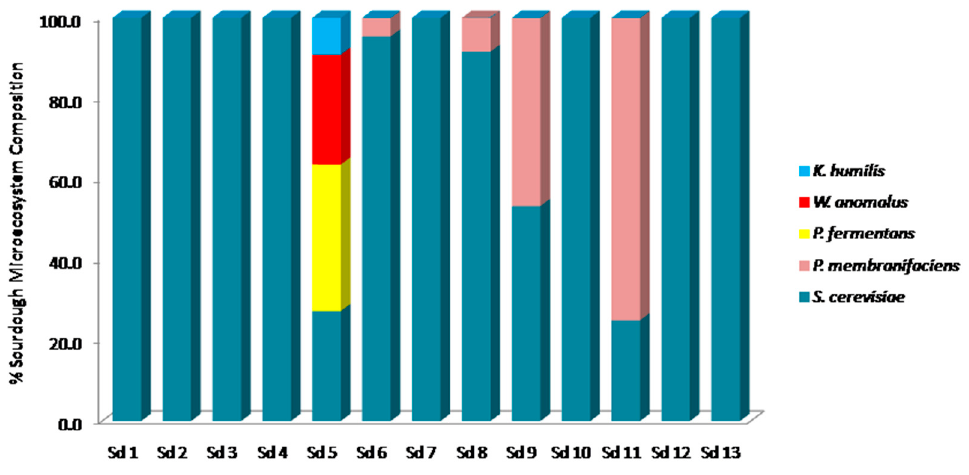
Figure 5. Yeast microecosystem composition of 13 Greek wheat spontaneous fermented sourdough samples. Sd: sourdough.